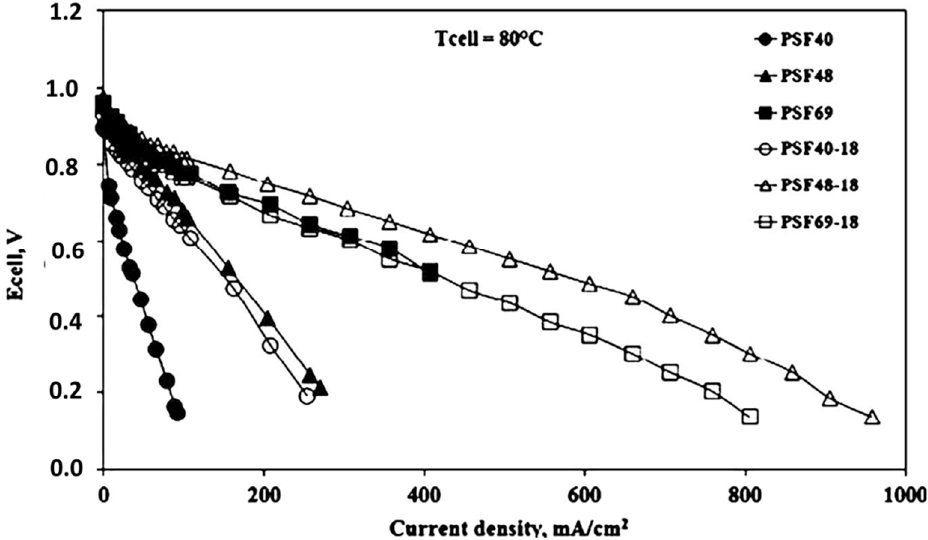
Figure 5. I–V profiles for s ‐ PSF and PSF ‐ 18 membranes at 80 °C. Reproduced with permission from